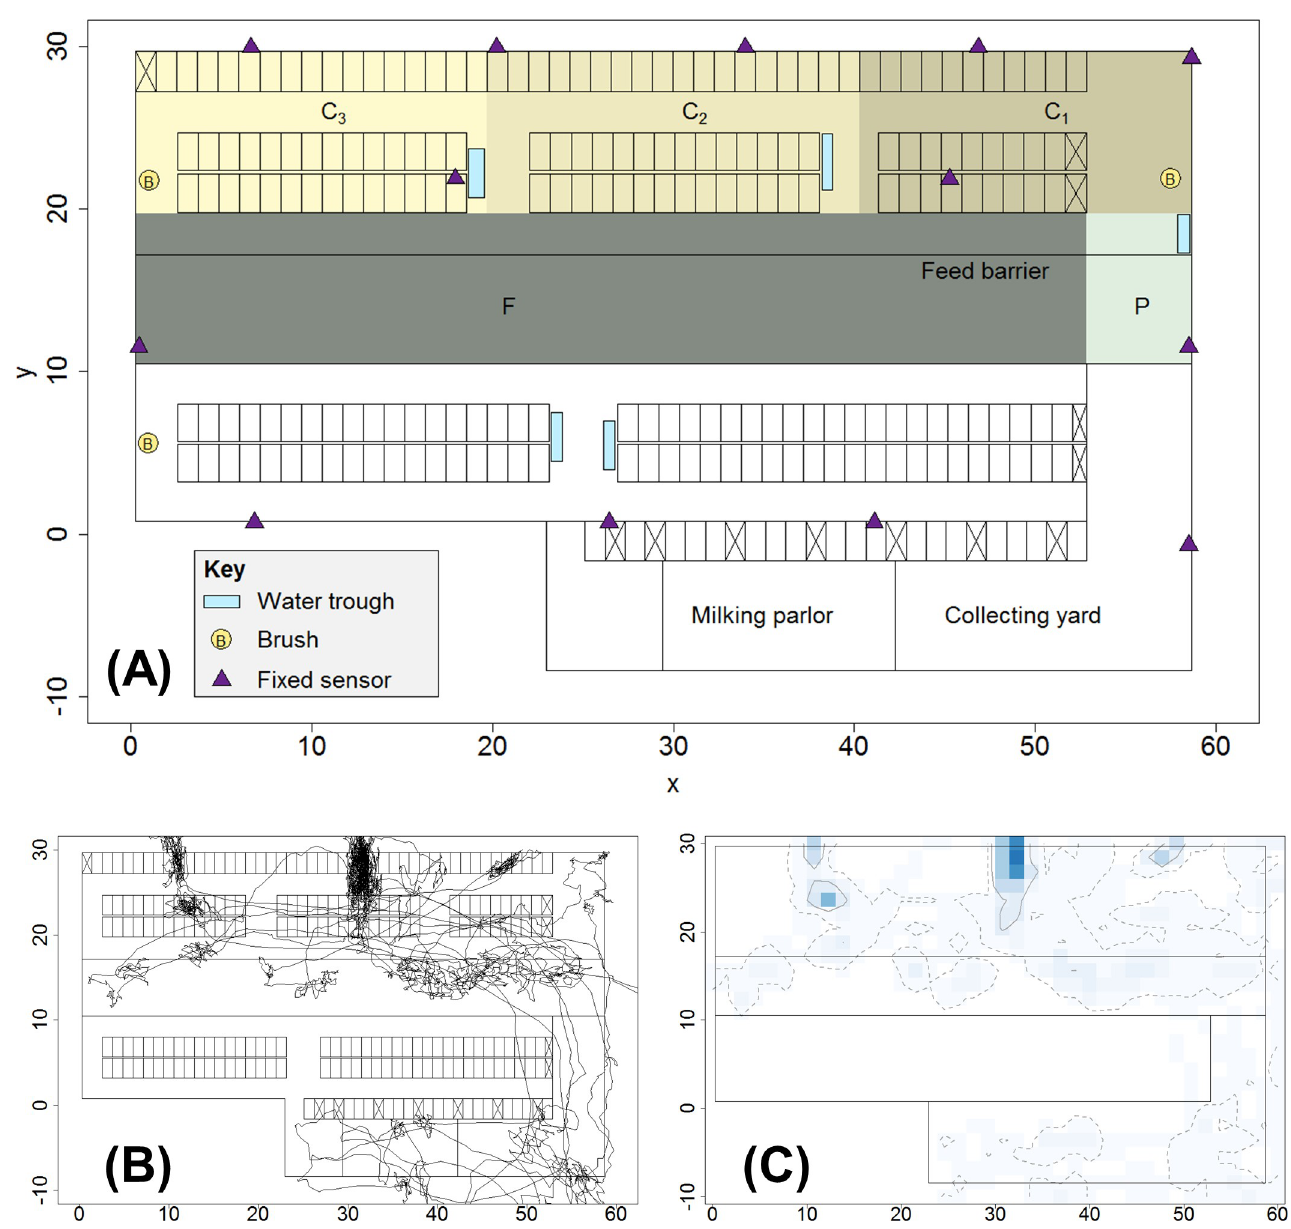
Fig 1. Schematic map of barn and examples of cow movement trajectory and space-use intensity. (A) Schematic map of barn indicating features and areas of interest. Fixed sensors were positioned on the barn walls to aid tracking of mobile cow-mounted sensors. Areas C 1 , C 2 and C 3 are zones defined to correspond to the three main cubicle blocks in the upper barn area (C T is the total cubicle area corresponding to the union of C 1 , C 2 and C 3 ); area F corresponds to the feeding zone and includes space either side of the feed barrier; area P is a passageway allowing access from the upper barn area to the collecting yard and milking parlour. (B) Example of a cow trajectory (cow 1078, day 5) produced by smoothing the raw sensor-collected data using a simple moving average over a 15 time-step (2 minute) moving window. (C) Example space-use intensity plot (cow 1078, day 5) produced by overlaying a 1.5m 2 square grid onto the map of the barn and counting the cells in which trajectory points are found. Darker colours correspond to higher space-use intensity. The 95% and 50% isopleths are respectively indicated by the dashed and solid contour lines. Note that the plot shows space-use data from the full barn for illustrative purposes; results in the main paper are for location data from the upper barn only, see Fig